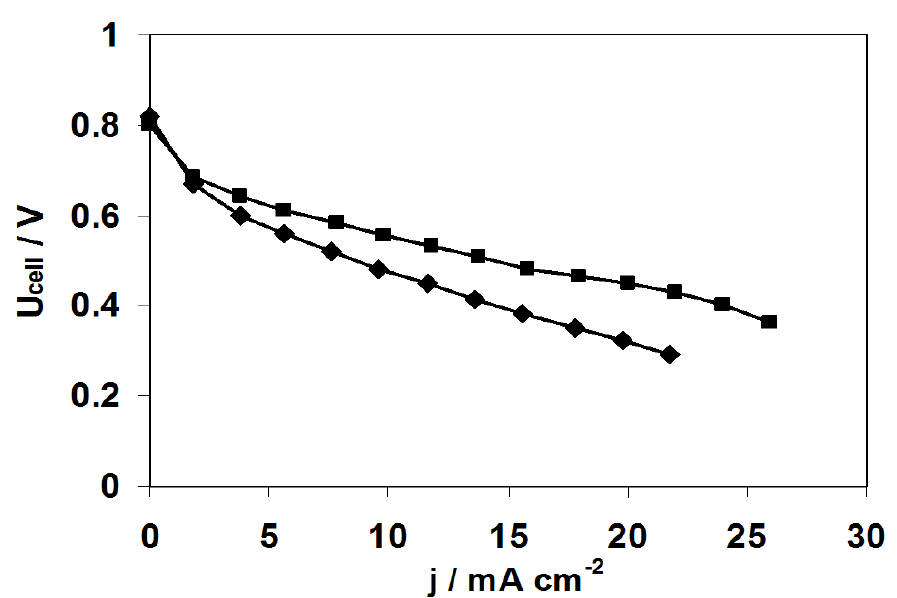
Figure 12. Polarisation curves recorded at 60 °C in SAFC fitted with MEA realized with pristine ADP-Morgane ® membrane (  ) and with one-side argon plasma treated membrane at 2 W for 10 min (  ). P = P = 1 atm, fuel flow rate = 0.8 mL min − 1 , fuel O2 flow rate = 40 mL min − 1 O 2